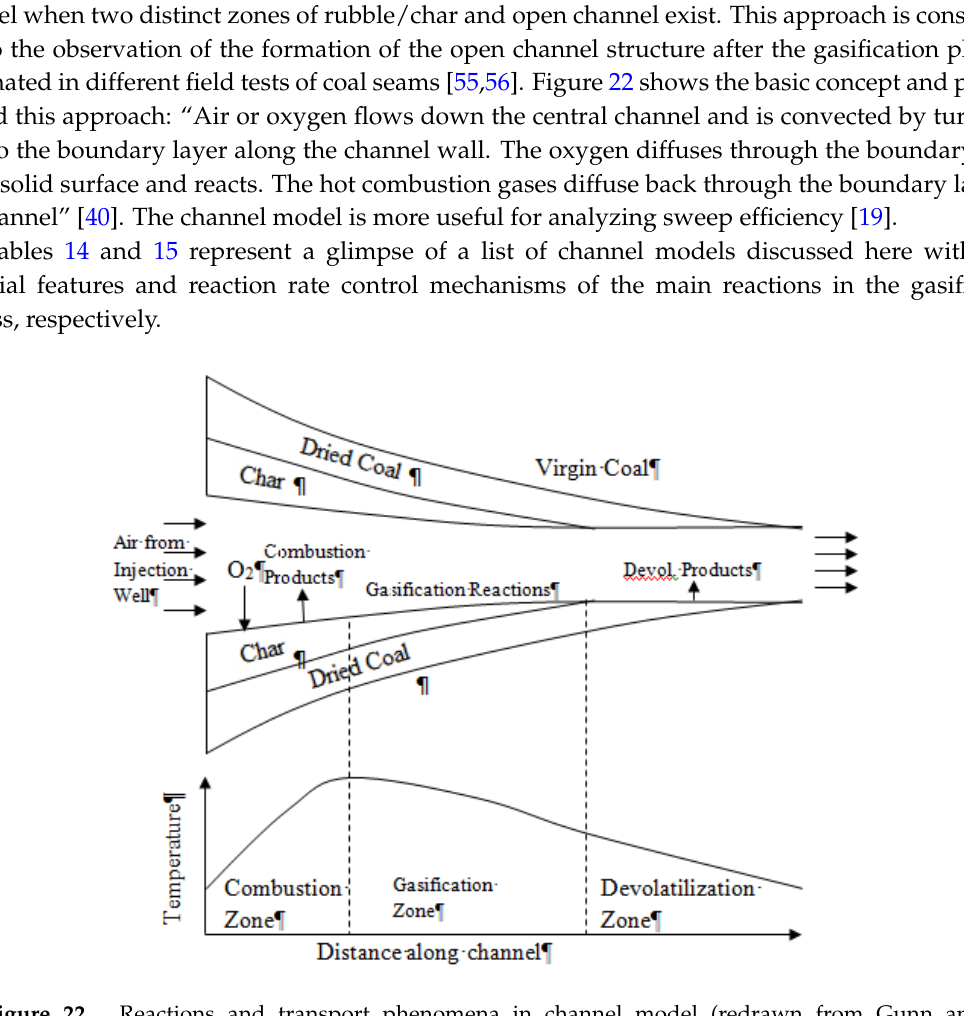
Figure 22. Reactions and transport phenomena in channel model (redrawn from Gunn and Krantz [40]).